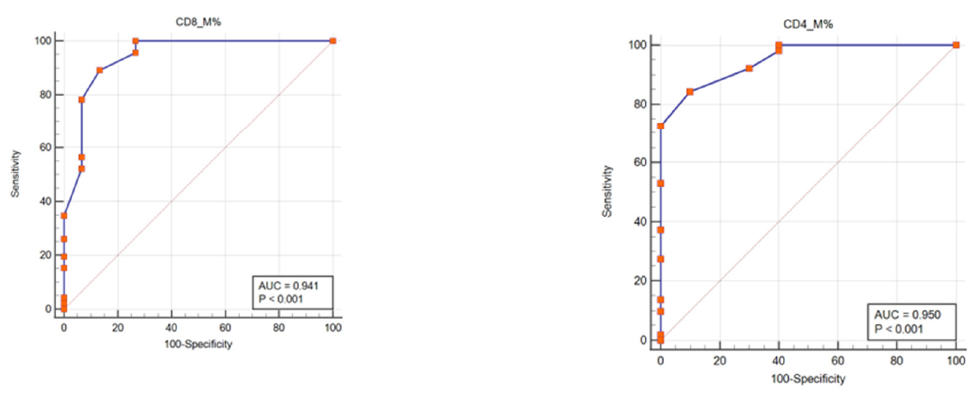
Figure 6. PD-L1, CD4, and CD8 tumor-infiltrating lymphocytes expressions patterns as potential